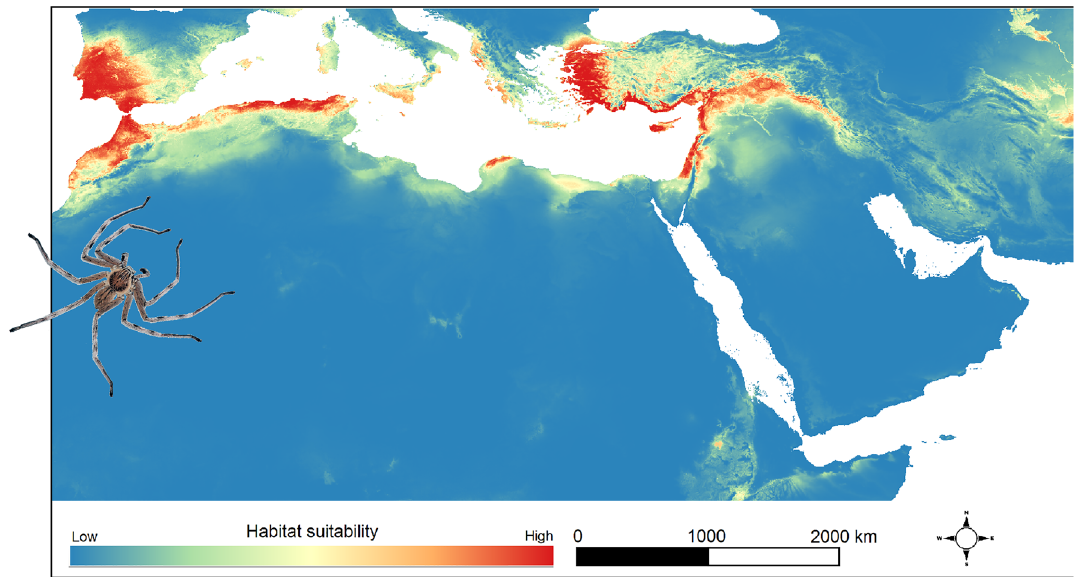
Figure 1. Distribution model of the dufouri clade. The distribution model was created using Maxent software 3.4.1 (https:// biodi versi tyinf ormat ics. amnh. org/ open_ source/ maxent/) and mapped in QGIS 3.22.3 (https:// www. qgis. org). The spider was photographed by Majid